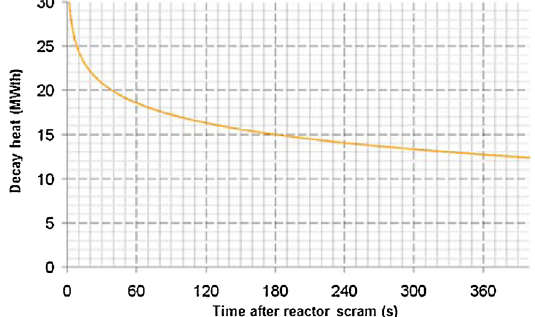
Fig. 7. Decay heat of Flexblue ® core.